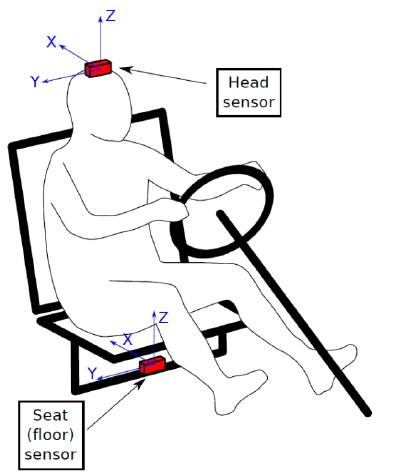
Figure 1. Scheme of the data acquisition process showing the location of the